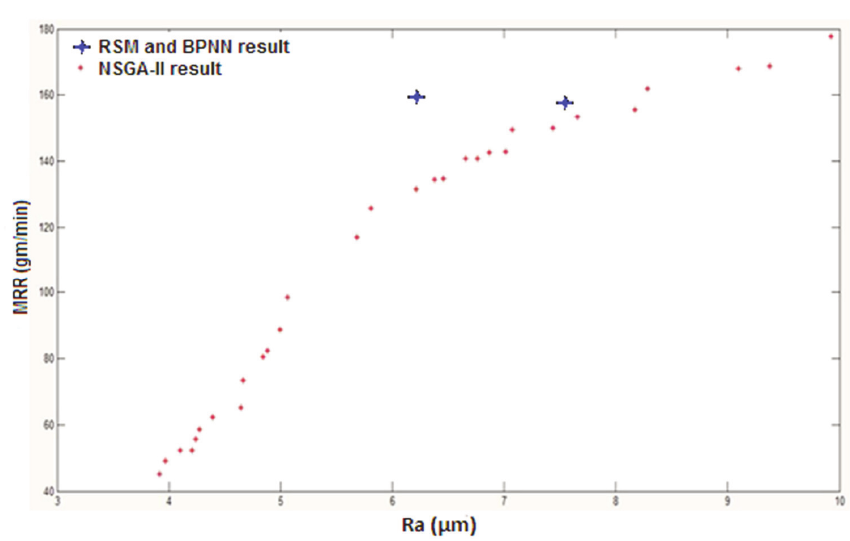
Fig. 1. Pareto optimal front and comparison of result for EDM